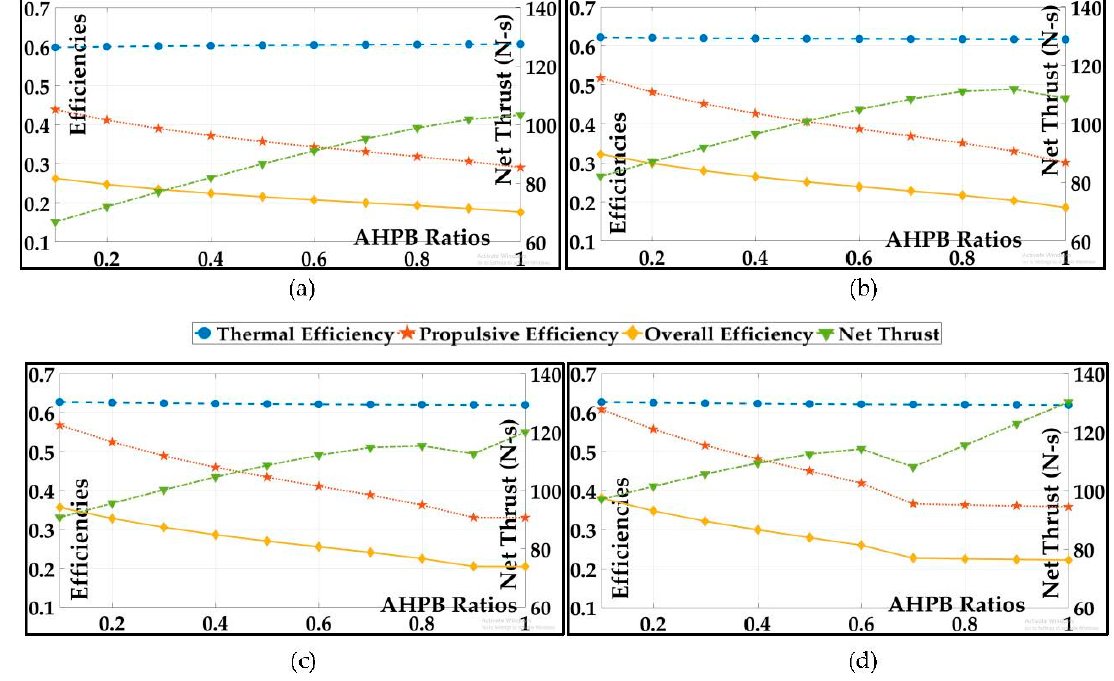
Figure 5. Plots of efficiencies and net thrust vs. AHPB ratios for ( a ) LPB = 2; ( b ) LPB = 6; ( c ) LPB = 10; ( d ) LPB = 12.